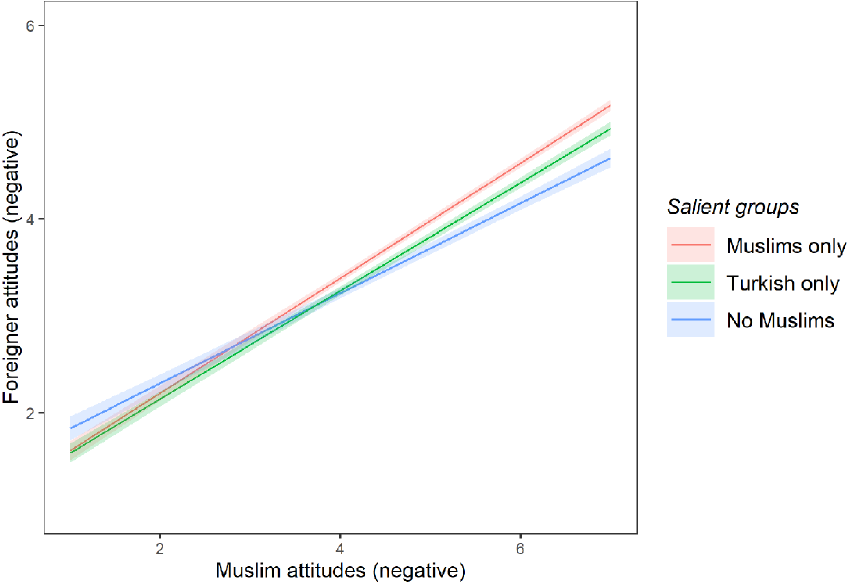
Figure 2. Association between attitudes towards Muslims and attitudes towards foreigners depending on salient groups (shaded band shows standard